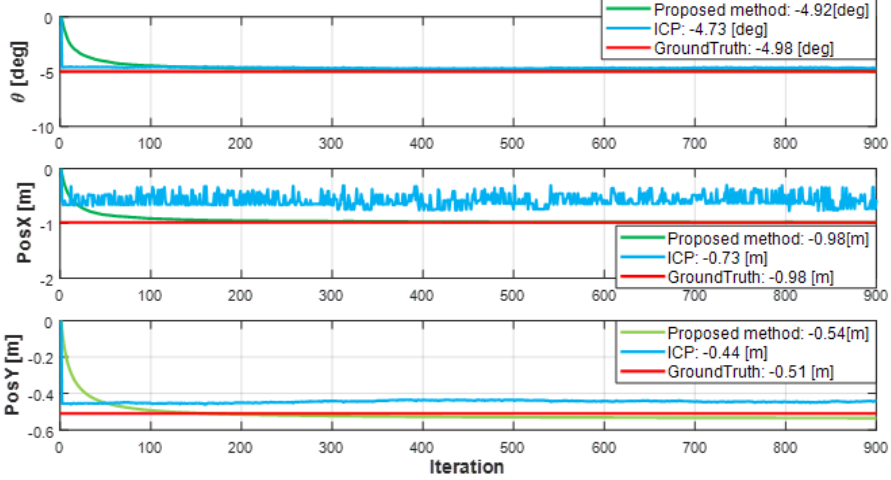
Figure 12. Results of model parameters